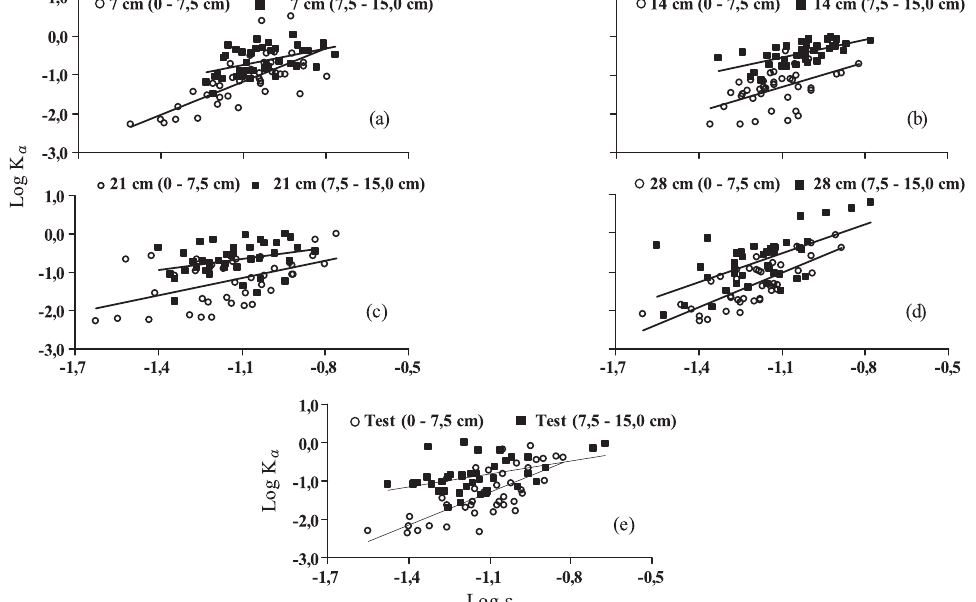
Figura 4. regressões de Log K a por Log e a nas camadas de 0–7,5 e 7,5–15 cm para as alturas de pastejo de 7 (a), 14 (b), 21 (c) e 28 cm (d) e a testemunha